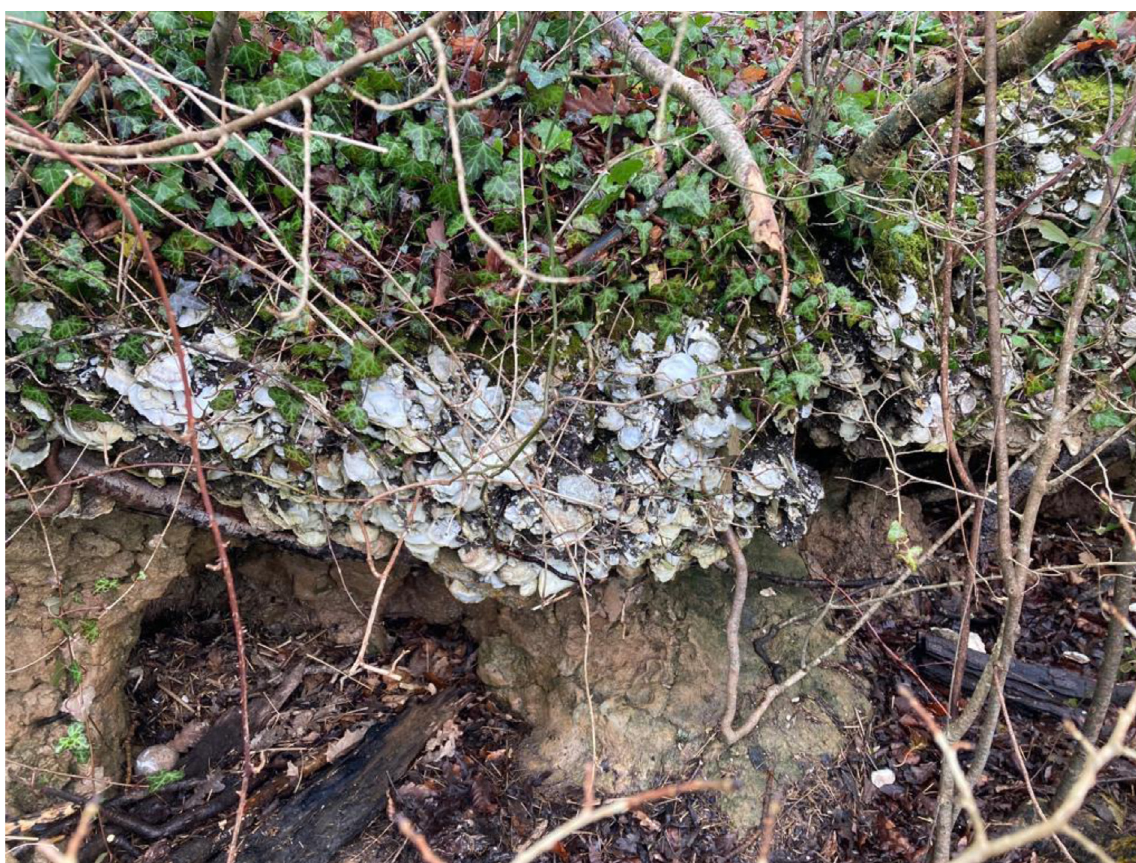
Fig. 4. Oyster shell buried in an estuary bank Lawrenny (site 12 in Fig. 1), from a historical oyster pickling station (2021). Pickled oysters were a valuable product in the 1700 – 1800 ’ s, and facilitated trade to other parts of Wales, England and outside the UK (Fenton, 1810).